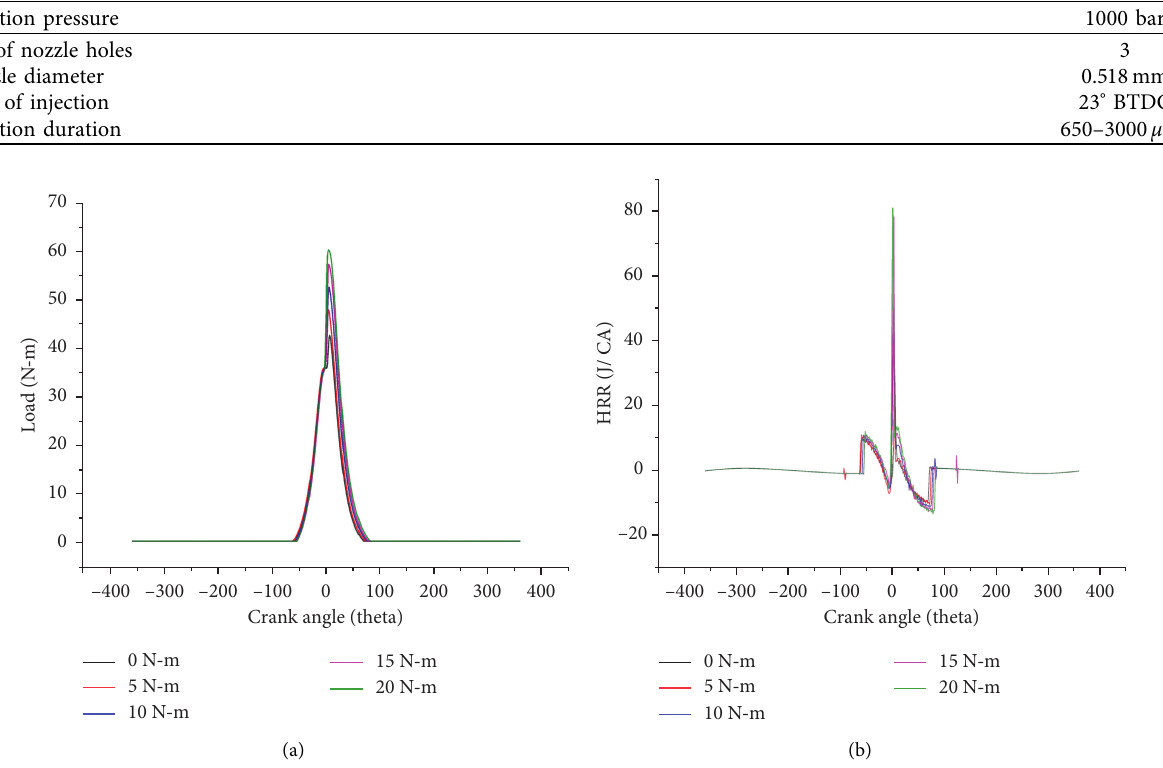
Figure 13: Curves for different load conditions with mechanical injection. (a) Load and crank angle curve. (b) HRR and crank angle